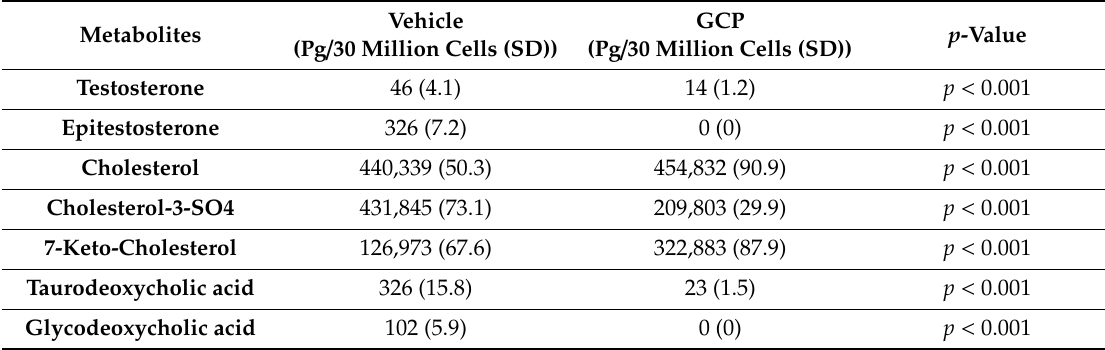
Table 1. Steroid composition analysis demonstrates that GCP can downregulate testosterone synthesis as well as the synthesis of other steroids by LNCaP cells. Data are shown as means (SD). The experiment was performed using triplicate